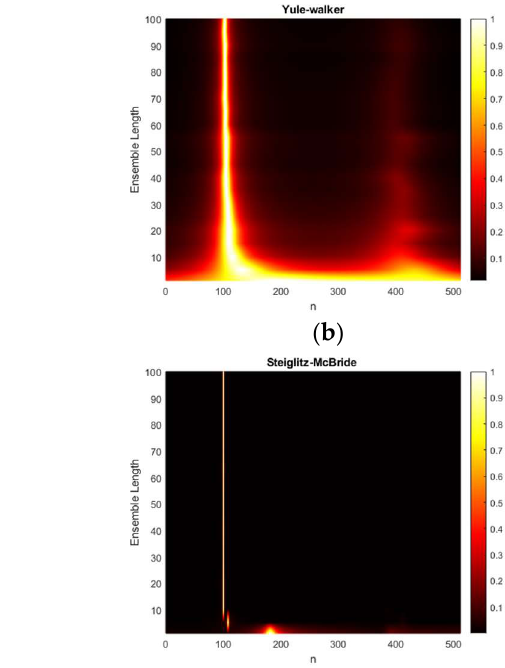
Figure 8. Estimated ℎ (cid:3560) [𝑛] distribution (normalized) with given SNR & 20 ensemble average from: ( a ) non-parametric HD top-view (interpolated); ( b ) Yule-walker HD top-view (interpolated); ( c ) Prony HD top-view (interpolated); ( d ) Steiglitz-McBride HD top-view (interpolated). Sensors 2020 , 20 , 925 17 of 31